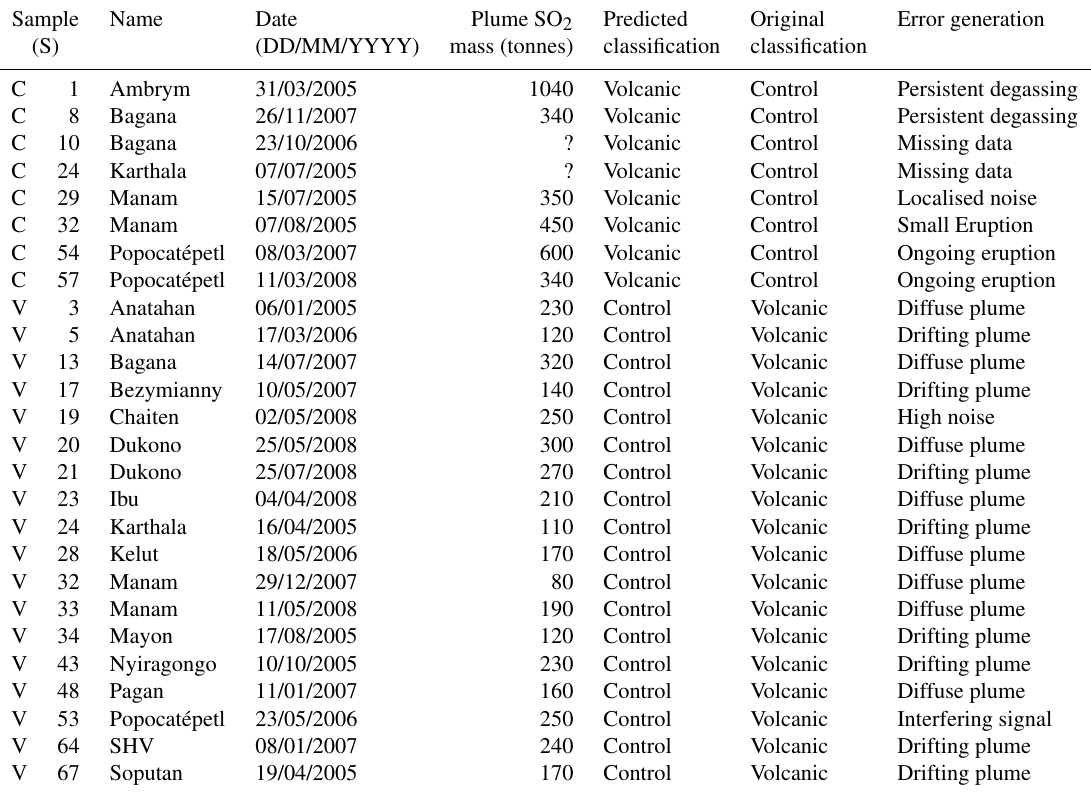
Table 4. Misclassified alerts identified in the initial logistic regression model.